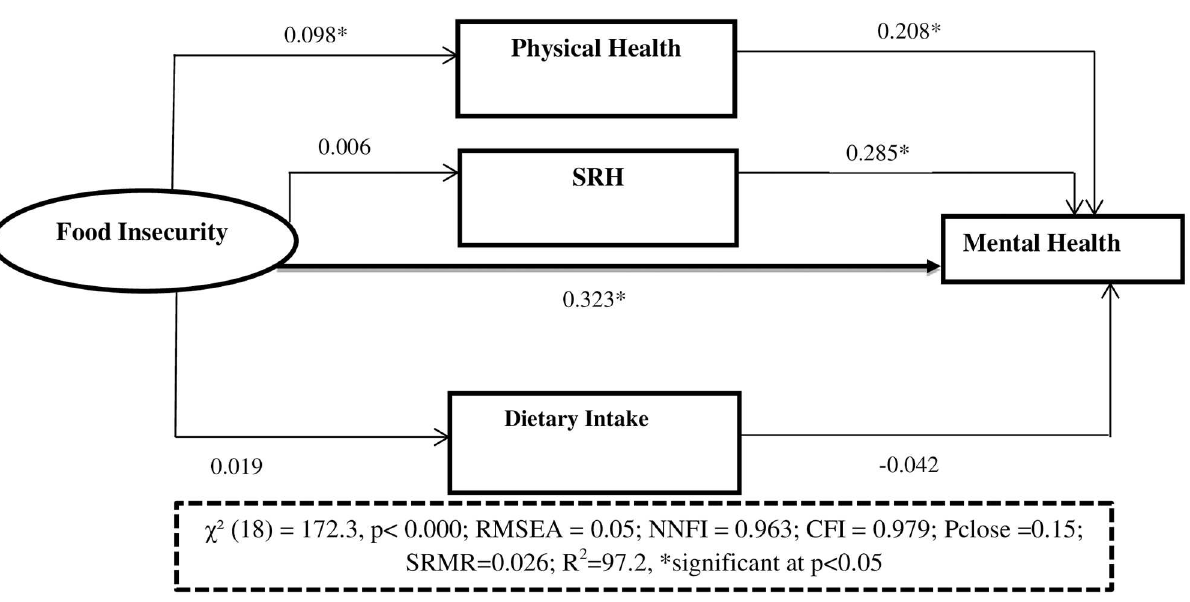
Fig 5. Full structural equation model showing the association between food insecurity and mental health, JLFYS, 2015.